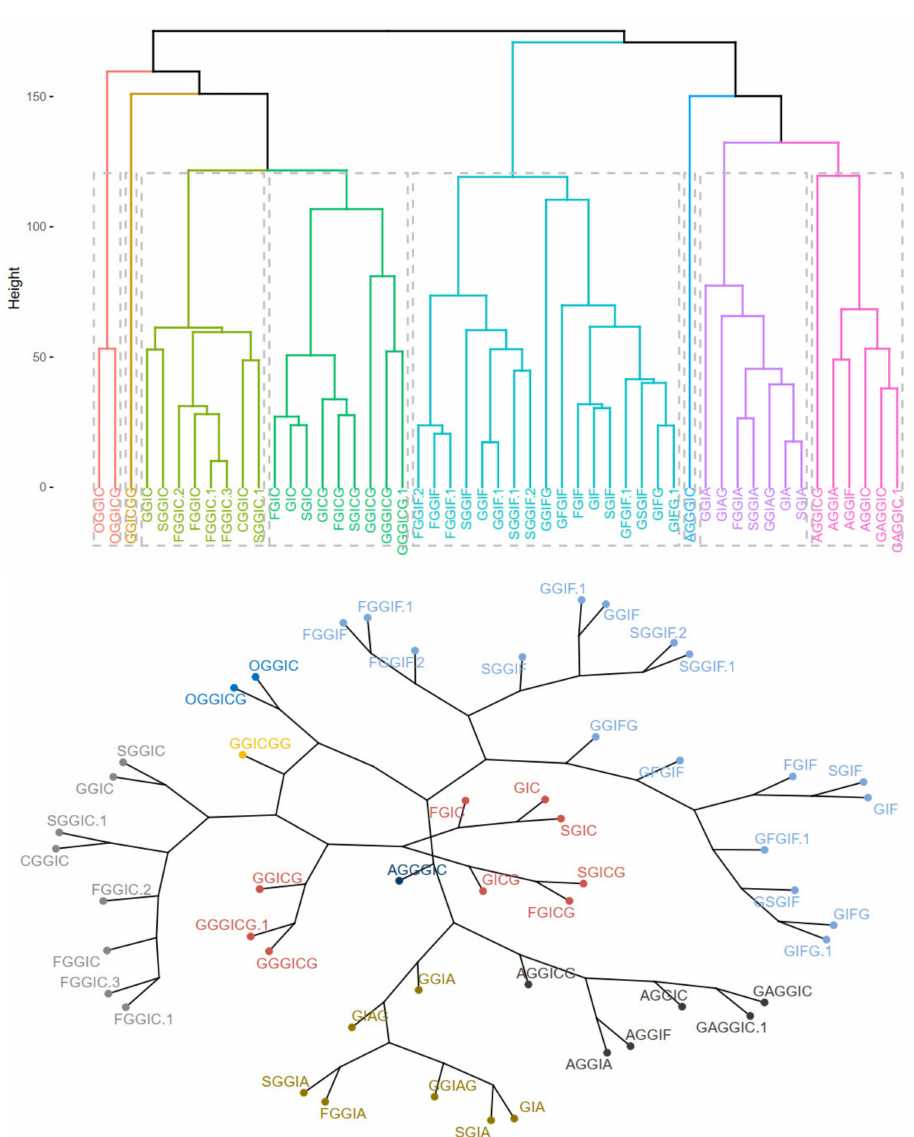
Figure 9. Dendrogram ( upper ) and phylogenetic tree-like dendrogram ( lower ) of the 51 identified